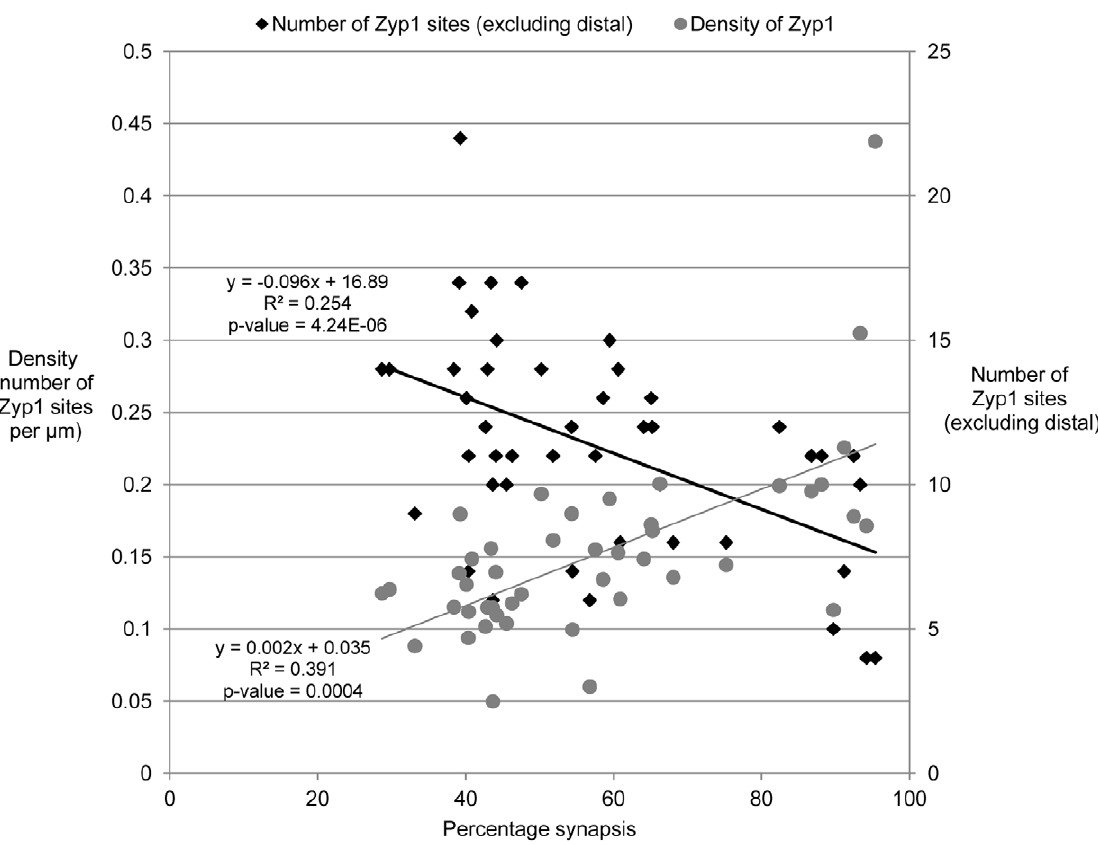
Figure 3. Density of ZYP1 in synapsing bivalents. Plot of the density of ZYP1 fragments in along the synapsing bivalent (grey circles), and the number of ZYP1 sites along the bivalent (excluding distal synapsis) (black diamonds) against percentage synapsis of 45 zygotene bivalents. P-values calculated using a 2 tailed t-test on the slope coefficient in a simple regression.